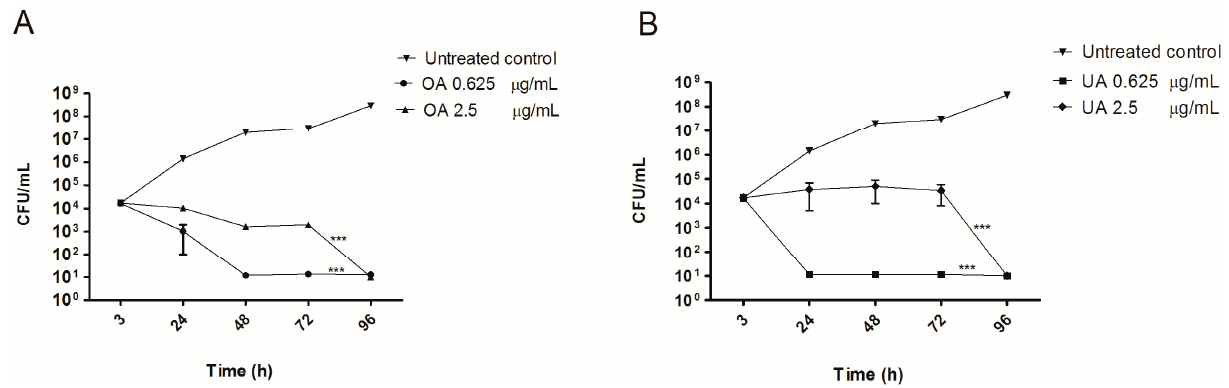
Figure 2. Enhancement of intracellular killing activity of macrophages against MTB by triterpenes. J774 A.1 mouse macrophages were infected with M. tuberculosis H37Rv